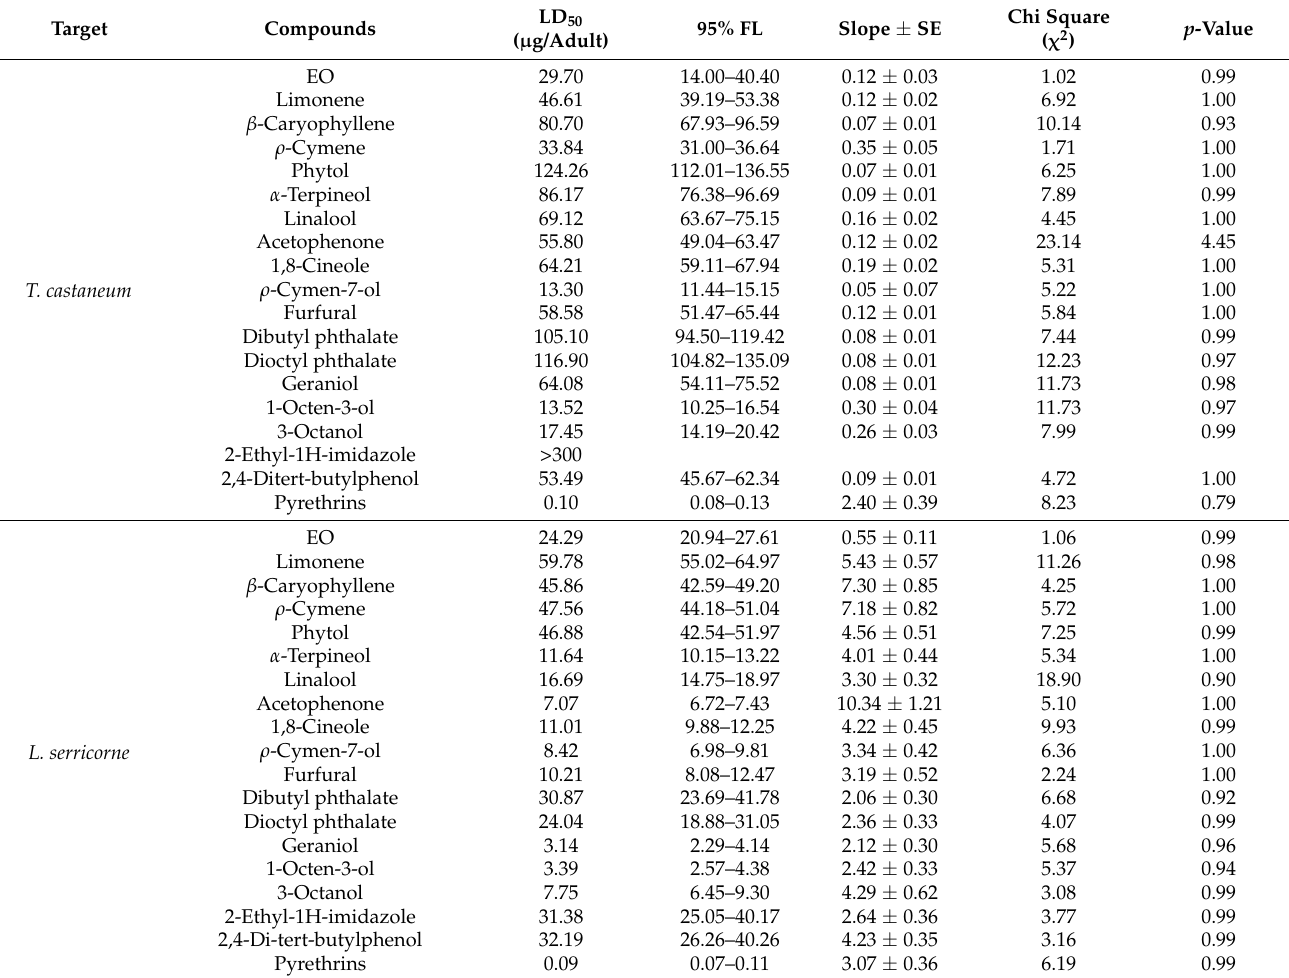
Table 4. Contact activity of compounds against T. castaneum and L. serricorne . Target